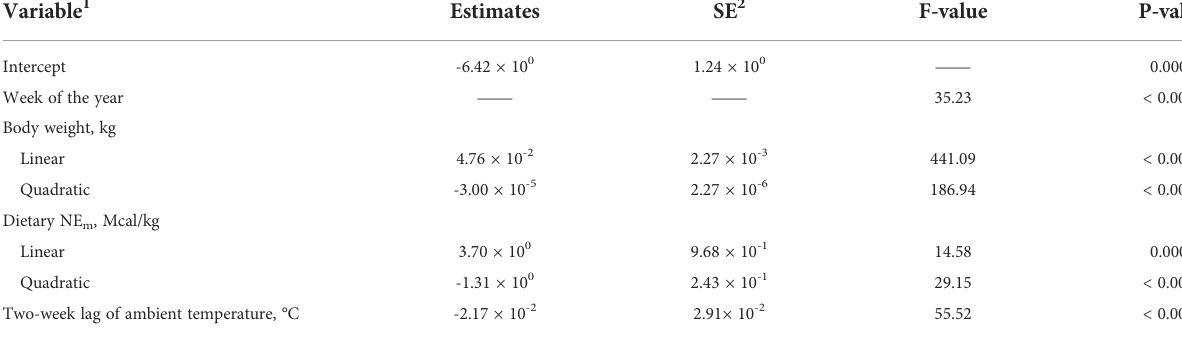
TABLE 5 Base model with two-week lag of ambient temperature.